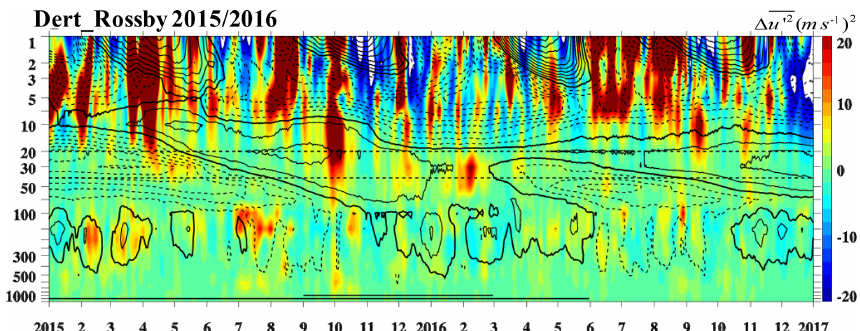
Figure 2. Temporal evolution of Rossby wave activity as squared zonal wind anomalies averaged over 10 ◦ S–10 ◦ N in the vertical direction. Color shading denotes the anomalies with respect to the monthly climatology (the unit is m 2 s − 2 ). The zonal mean zonal wind is overlaid in black contours with contour interval of 5ms − 1 . The solid and dotted black contours denote westerly and easterly winds, respectively. The thick contours represent the zero wind line. The horizontal dashed lines denote the altitudes of 20 and 40hPa. The horizontal solid lines denote the El Niño (single line) and strong El Niño periods (double line) in the bottom.